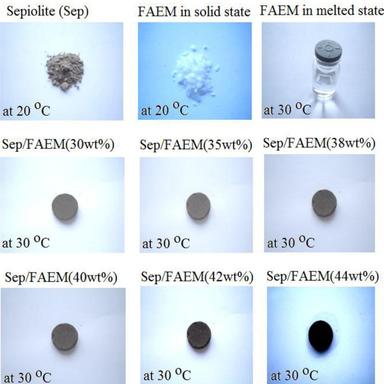
The leakage test results of Sep/FAEM composites.